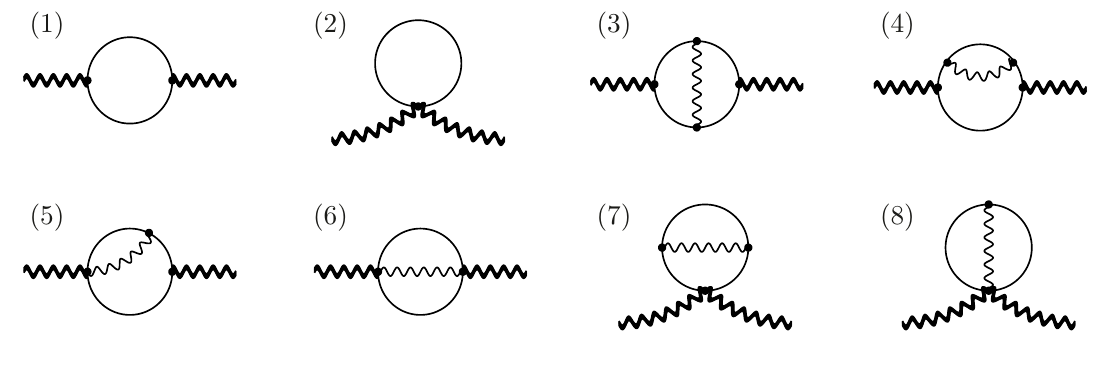
Figure 2 . The superdiagrams giving the two-point Green function of the Abelian gauge superfield V in the two-loop